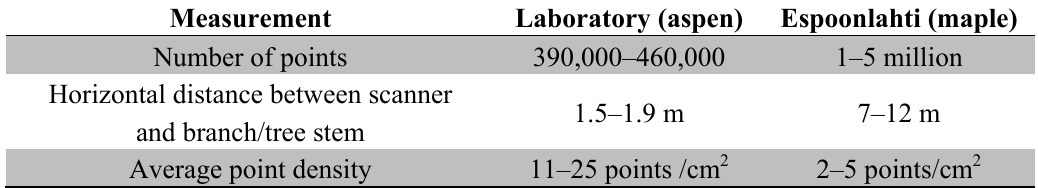
Table 2. Measurement specifications for the laboratory and field